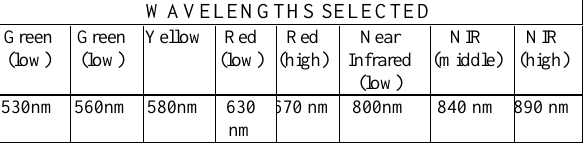
Wavelengths used to correspond with TM from Landsat and SPOT WAVELENGTHS SELECTED Green Green Yellow Red Red (low) (low) (low) (high)